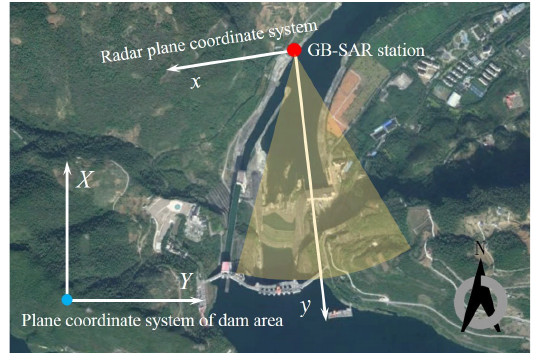
Figure 5. Relation of dam and radar plane coordinate